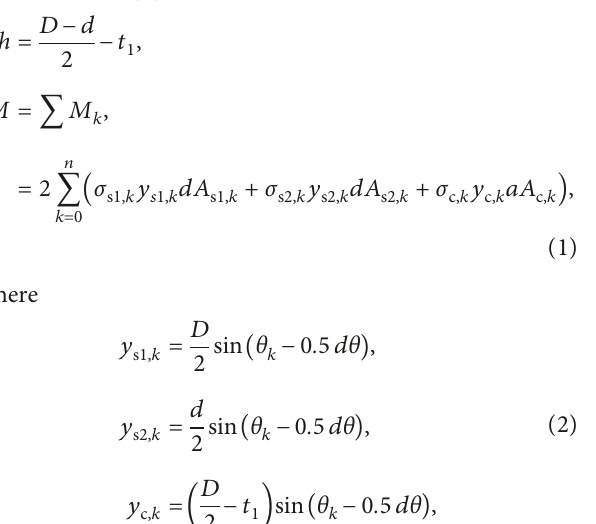
Figure 1: DWHP section